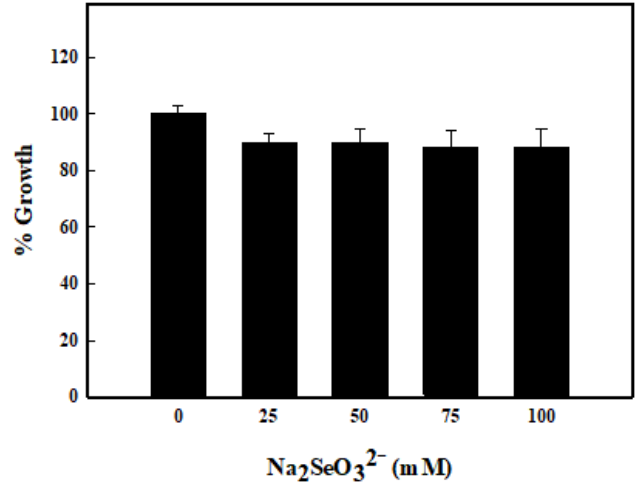
Figure 1. Selenite resistance by Stenotrophomonas acidaminiphila . The experiment was performed in triplicate.